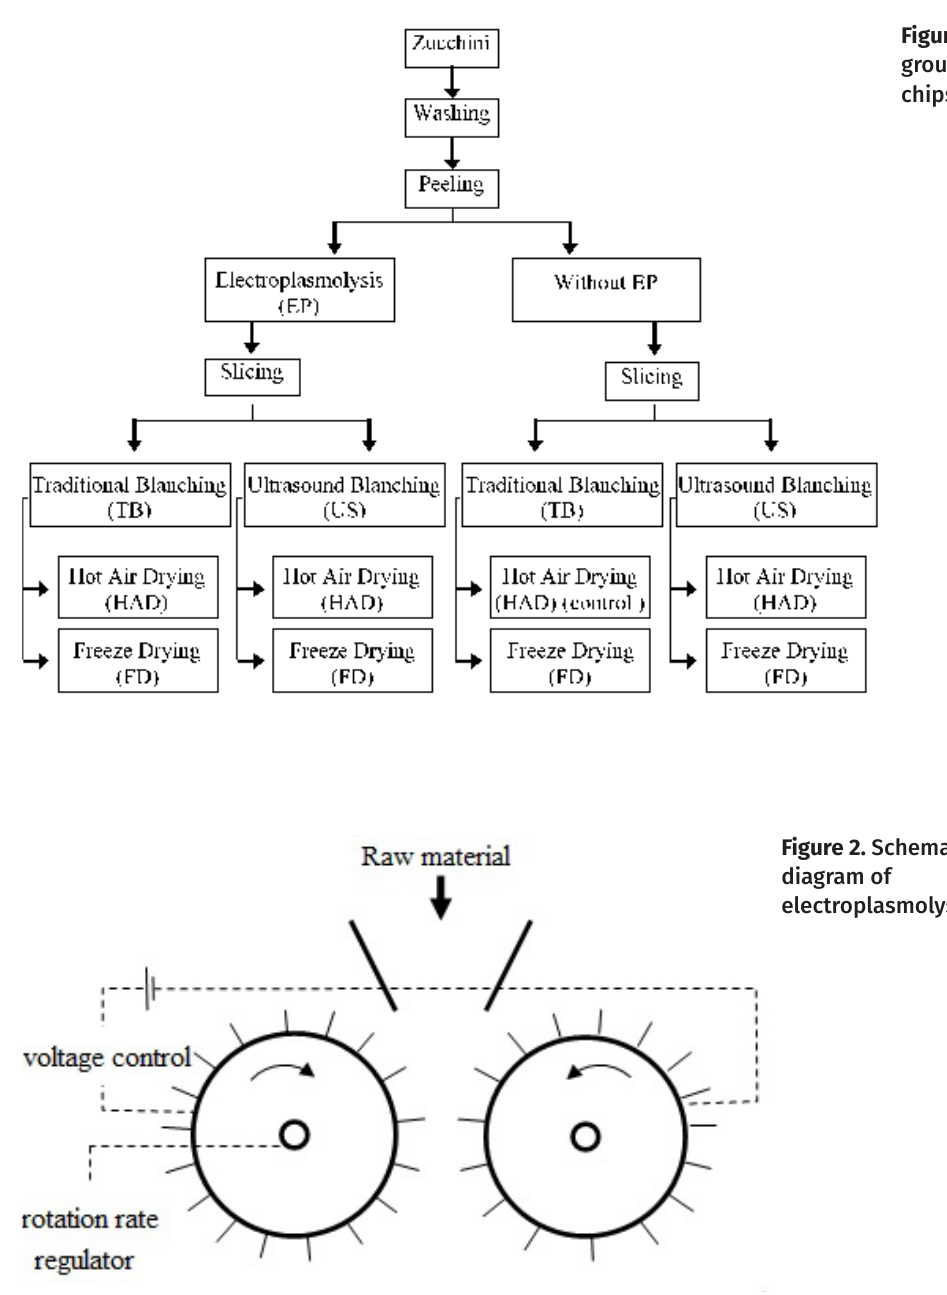
Figure 1. Processing groups zucchini chips.